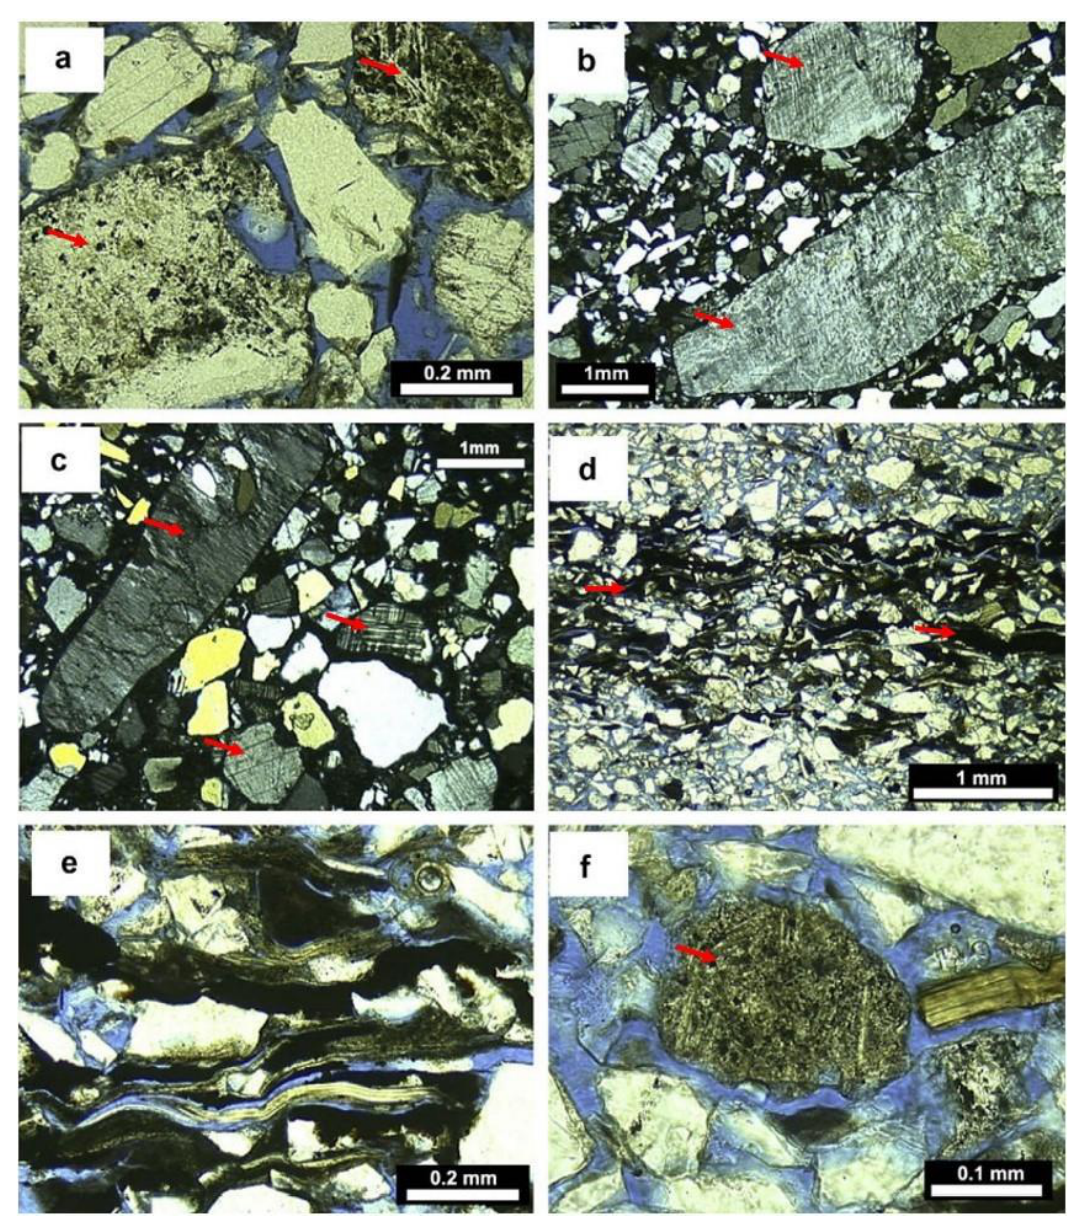
Figure 13. Photomicrographs of the Maastrichtian reservoir (Well 05) of the Carapebus Formation: photos ( a , d , e , f ) with uncrossed polarizers; b and c with crossed polarizers. ( a ) Poorly sorted sub- angular medium-grained sandstone, lithic arkose; observe the volcanic rock fragments (indicated by red arrows). ( b ) Very poorly sorted subangular medium-grained sandstone, arkose; observe the pebble-sized feldspar grains (indicated by red arrows). ( c ) Poorly sorted subangular coarse-grained sandstone, arkose; observe the pebble-size feldspar grains (indicated by red arrows). ( d ) Moderately sorted subangular fine-grained sandstone, arkose; observe the high content of micaceous grains and of black carbonaceous fragments of burned wood (indicated by red arrows). ( e ) Detail of the compacted carbonaceous fragments and micas. ( f ) Moderately sorted subangular fine-grained sandstone, lithic arkose; observe the volcanic rock fragment (indicated by red arrow), adapted from Fetter et al.